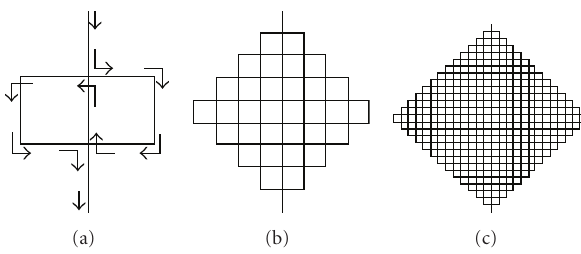
Figure 1: Hilbert curve (iteration 1, iteration 2, and iteration 3).